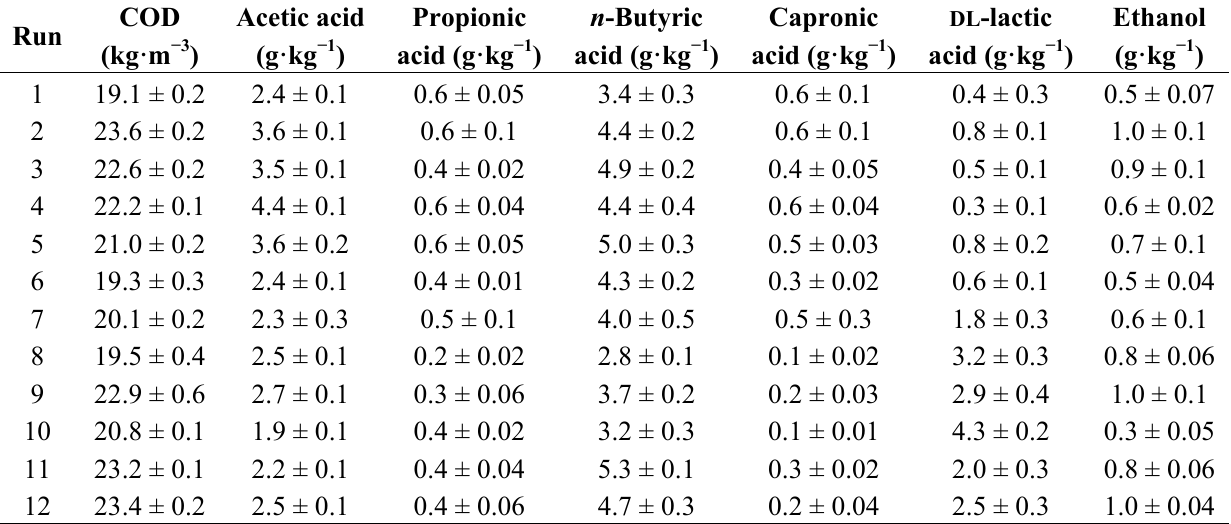
Table 3. Organic composition of the leachate as substrate for the pressurized anaerobic filter